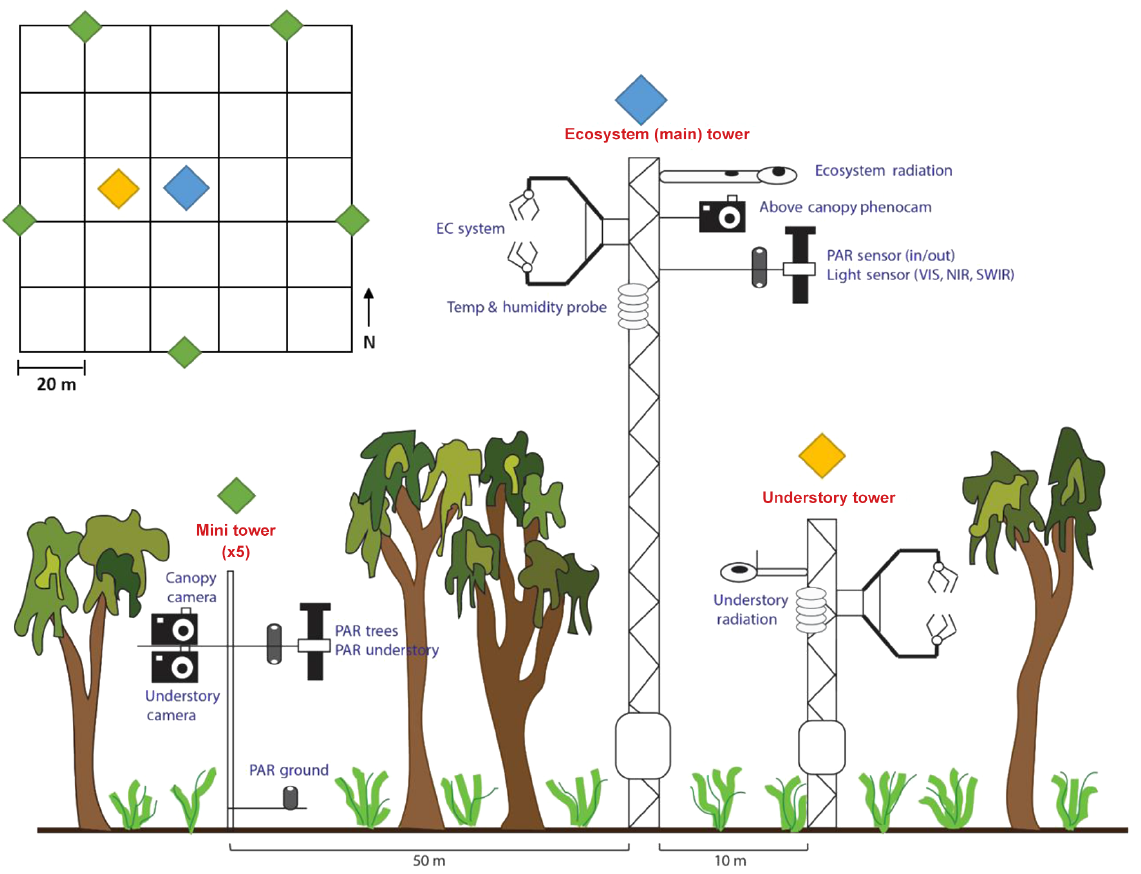
Figure 1. Diagram showing the core instrumentation supported by each flux tower and mini tower at the Howard Springs OzFlux site, as well as the layout of the monitoring